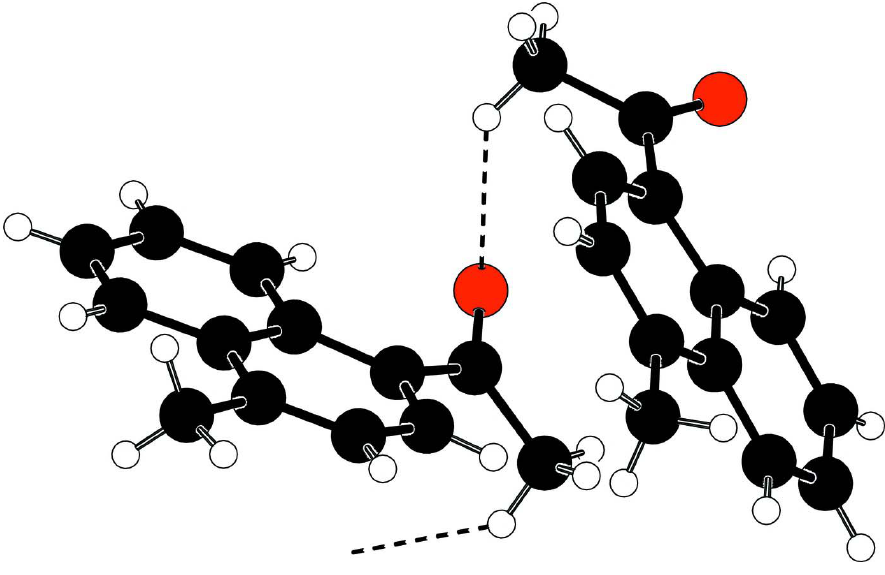
Figure 1 The molecular structure of the title molecule, with the atom- numbering scheme. Displacement ellipsoids are drawn at the 30% probability level. Hydrogen bond is shown as dashed